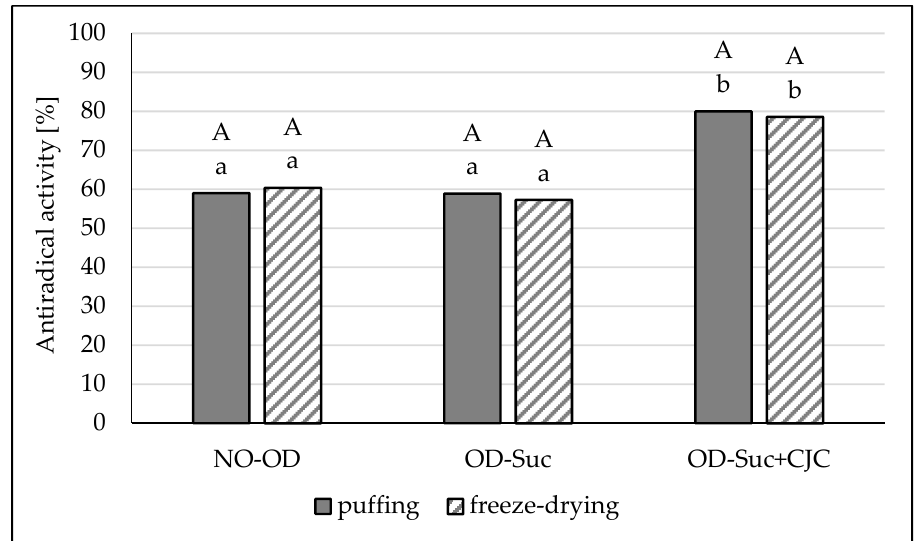
Figure 4. The influence of type of osmotic solution and drying method on the antiradical activity in apple samples: dried by “puffing” or freeze-drying way; no pre-treated (NO-OD), pre-osmotic dehydrated in sucrose (OD-Suc) or in sucrose with chokeberry juice concentrate solution (OD-Suc + CJC). The same letter, a, b, c, indicates a lack of statistically significant differences in type of osmotic solution and A, B in drying method.